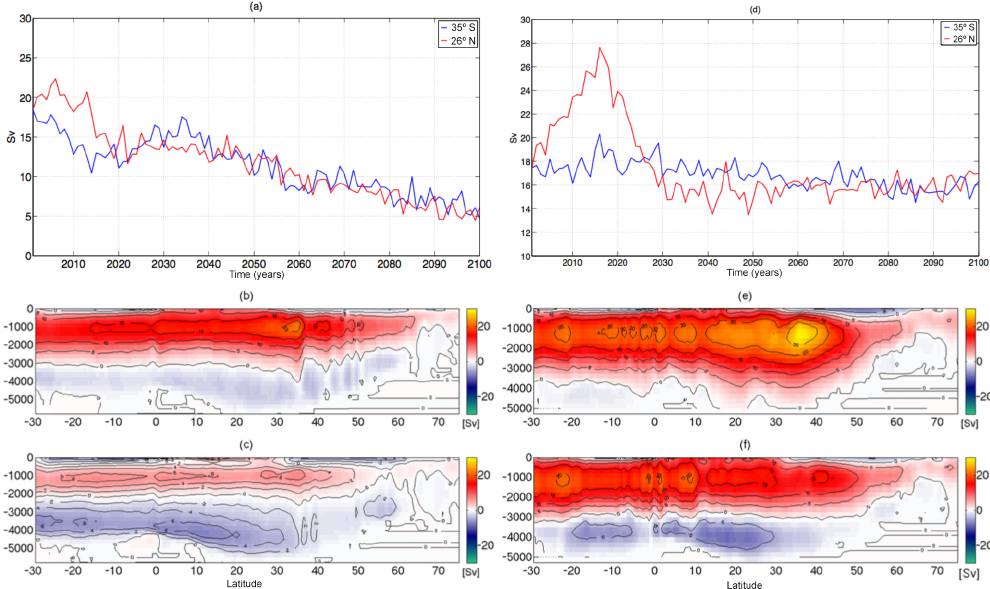
Figure 4. (a, d) Maximum AMOC strength at 35 ◦ S (blue) and 26 ◦ N (red) over the period 2000–2100 of (a–c) R 021 and (d–f) R low (b, e) AMOC streamfunction (mean of years 2001–2020); (c, f) same as (b) and (e) but over the period 2081–2100.